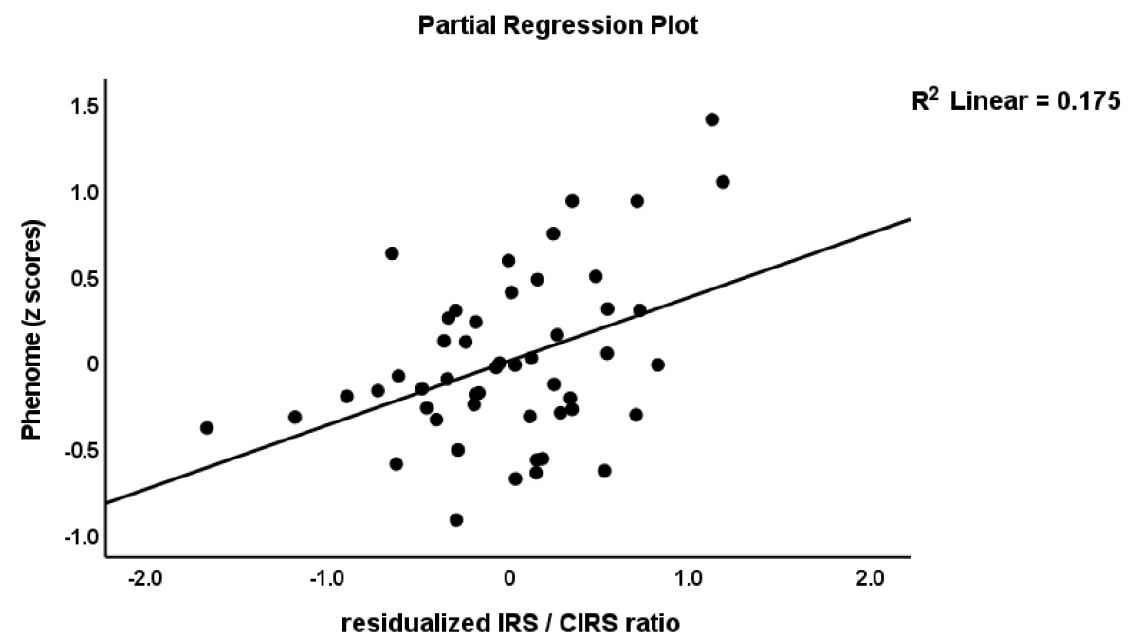
Figure 4. Partial regression plot of the phenome score on the immune-inflammatory response system (IRS)/compensatory immune-regulatory system (CIRS) ratio.